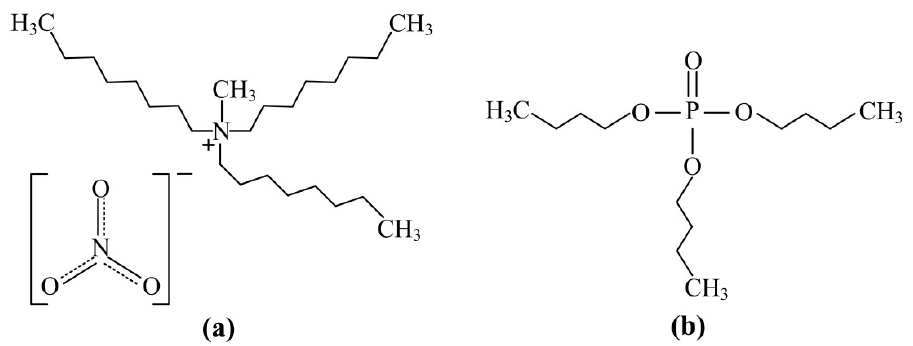
Figure 3. Structure of methyltri-n-octylammonium nitrate ( a ) and tri-n-butyl phosphate ( b ). By dissolving precisely weighed quantities of REE oxides in the estimated amount of concentrated HNO 3 solution stock mixed nitrate solutions of La(III), Pr(III), and Nd(III) were prepared. After complete dissolution of the REE oxides, an exactly weighed amount of crystalline Ce(NO 3 ) 3 · 6H 2 O was added to the solution. After Ce(NO 3 ) 3 · 6H 2 O dissolution, the content of HNO 3 in nitrate solution was adjusted to 0.1–0.2 mol/L by adding an esti- mated quantity of 1.0 mol/L HNO 3 or by neutralizing of excessive acid with 1.0 mol/L NH 4 OH solution.